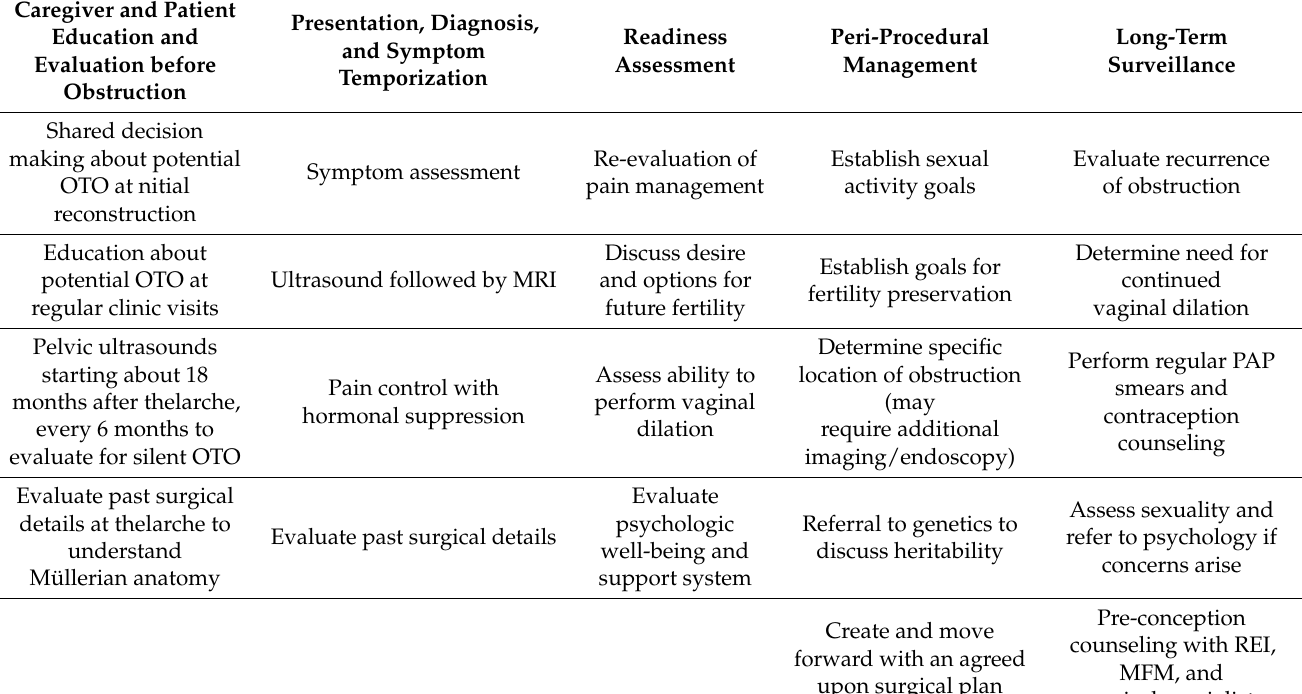
Table 2. Management Recommendations at the Different Phases of Müllerian Outflow Tract